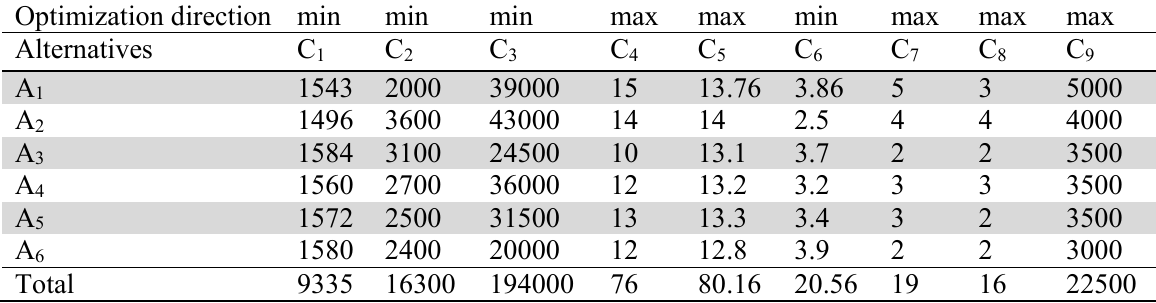
Quantitative data for performance evaluation of alternatives Optimization direction